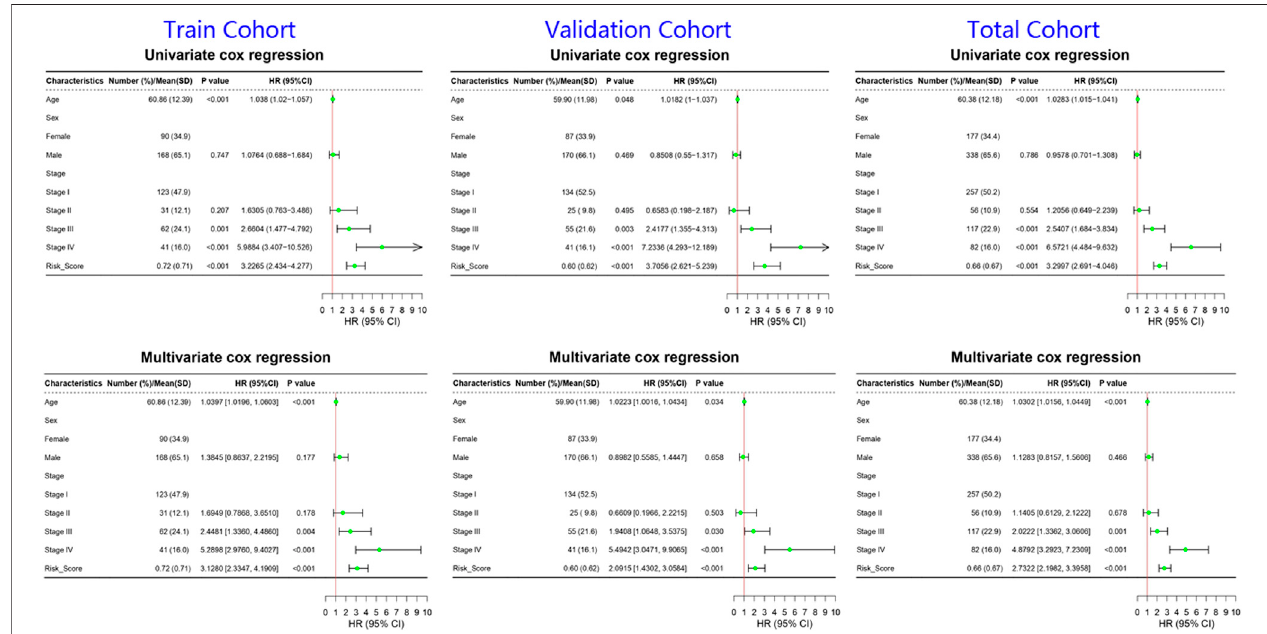
FIGURE 6 | Forrest plots of univariate and multivariate cox regression of ccRCC patients in train cohort, validation cohort, and total cohort. The green nodes represented HR and the line extending from the nodes indicated 95% CI.